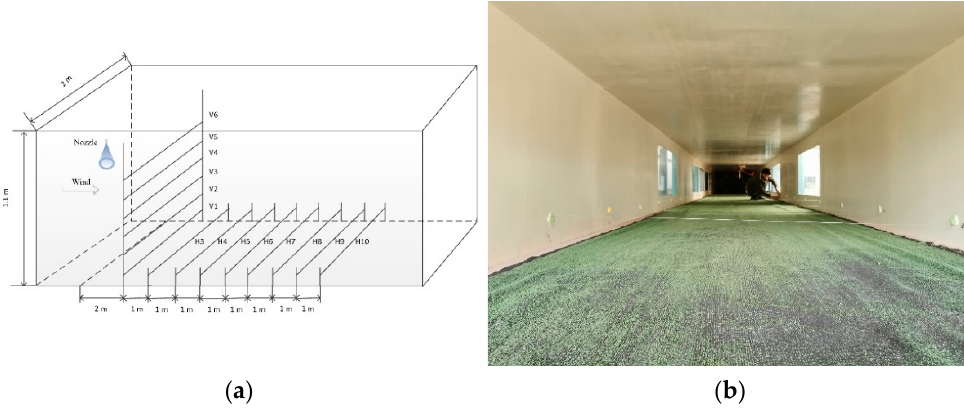
Figure 2. Wind tunnel used in this experiment. ( a ) Inner dimensions and sampling line layout. ( b ) Internal structure diagram of physical wind tunnel.